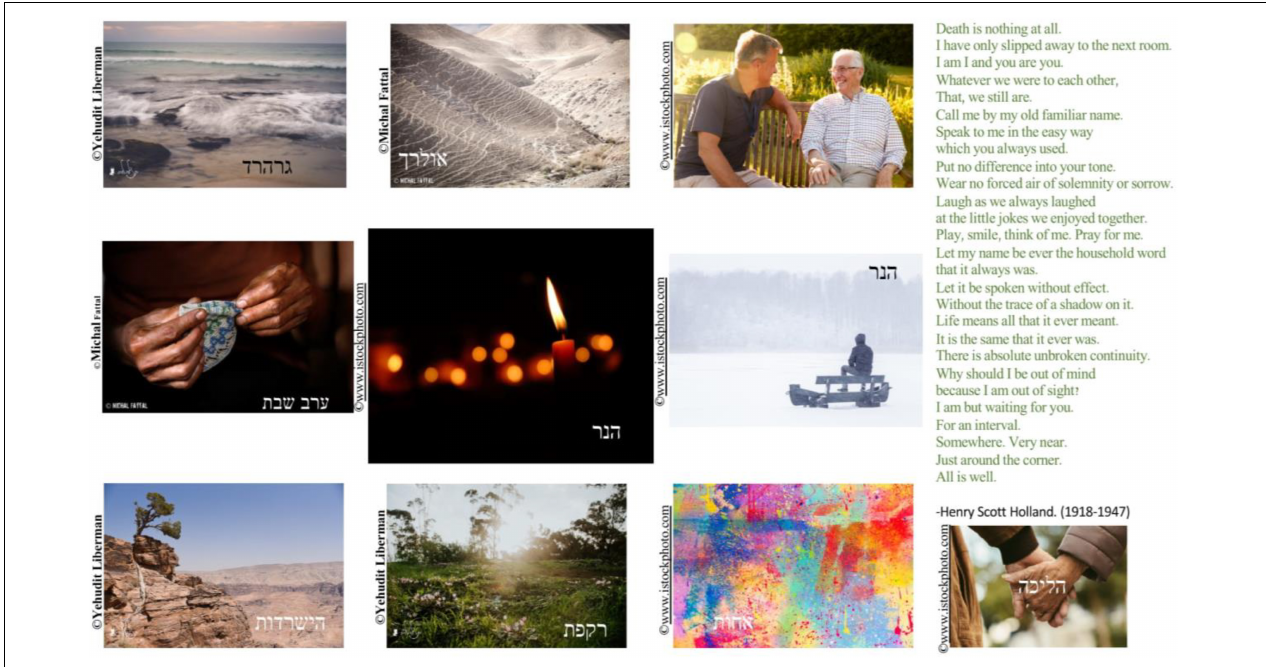
FIGURE 10 | Moshe’s photocollage (untitled).